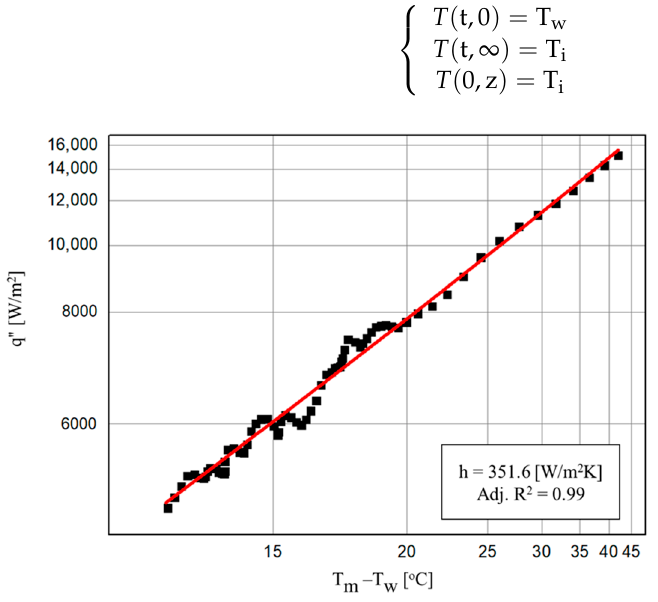
Figure 6. Linearity of the heat flux (q ″ ) and temperature difference (T m − T w ). The uncertainty of the measured heat transfer coefficient was estimated using Equations (7) and (8) [21–23]. To estimate the uncertainty, measurement uncertainties Δ T m , Δ M, Δ t, and Δ T w were assumed to be 0.3 °C, 5%, 1/30 s, and 0.5 °C, respectively. The resulting uncertainties were 13.4% and 8.97% for the HTC at 1192 W/m 2 K and 279 W/m 2 K, respec ‐ tively.